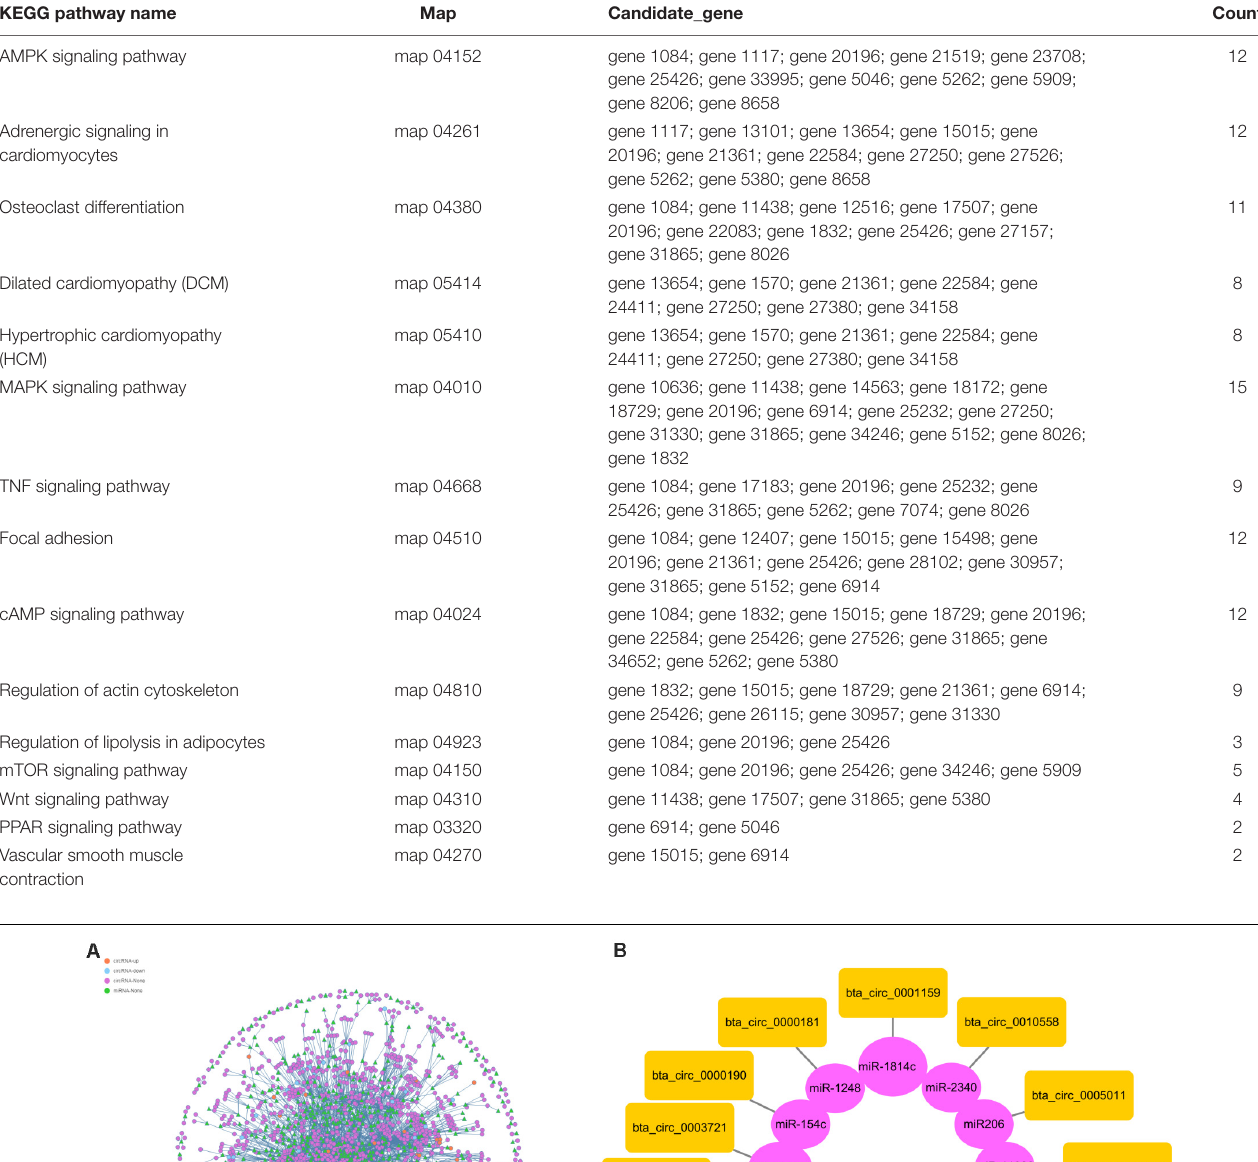
TABLE 4 | List of significantly enriched KEGG pathways related to muscle development.